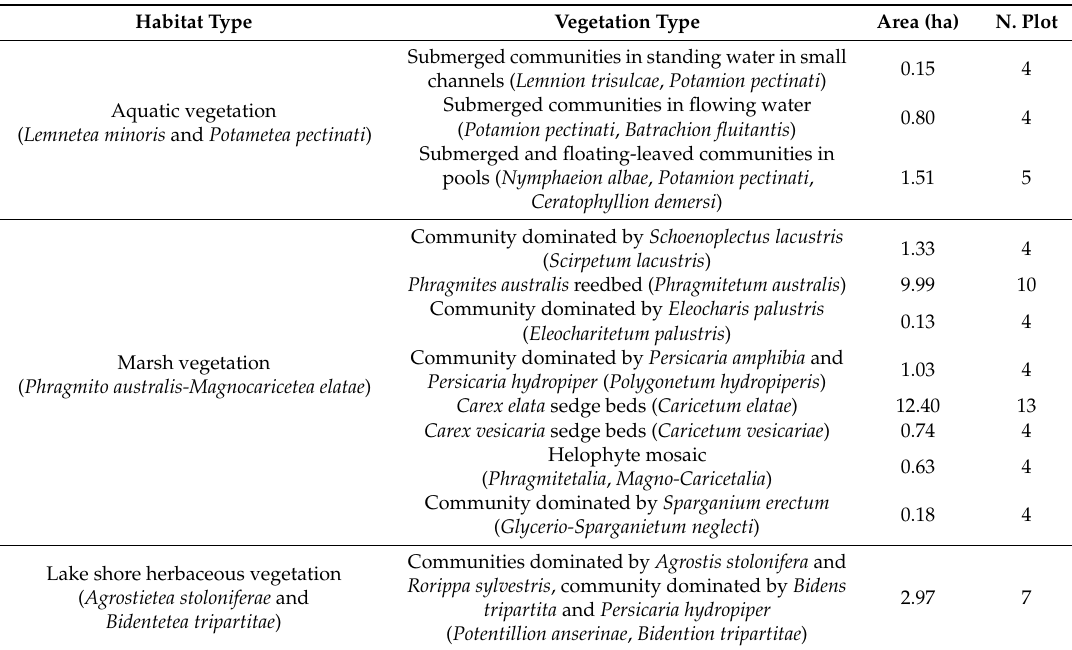
Table 1. Description, extent and number of sampled plots referring to the vegetation types of the wetland protected area (PA) included in the main